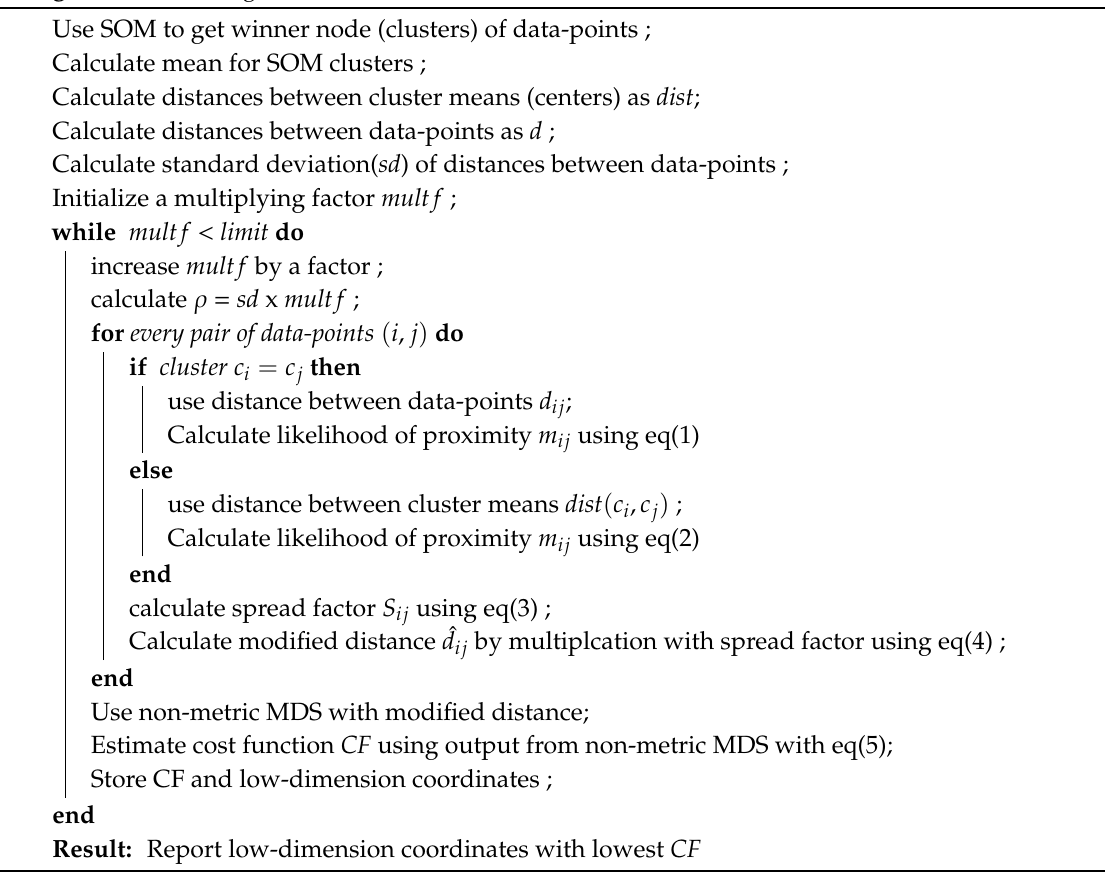
Algorithm 1: The algorithm of